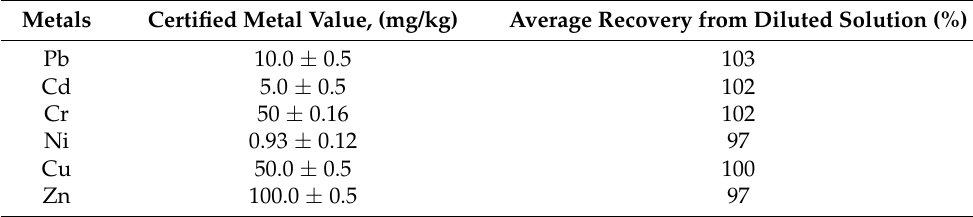
Table 1. Analysis of Certified Reference Material for